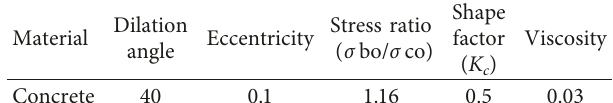
Table 1: CDPM parameters.